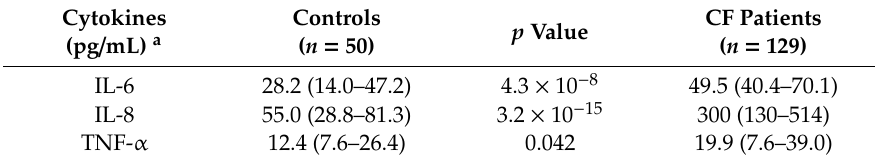
Table 3. Salivary IL-6, IL-8, and TNF- α levels in control subjects and in adult patients with CF.